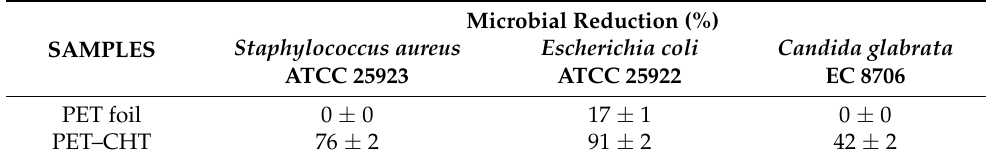
Table 1. Reduction, R (%), of selected microorganisms after exposure to differently treated PET foil, as obtained by ASTM E 2149-01 (2002) standard test.